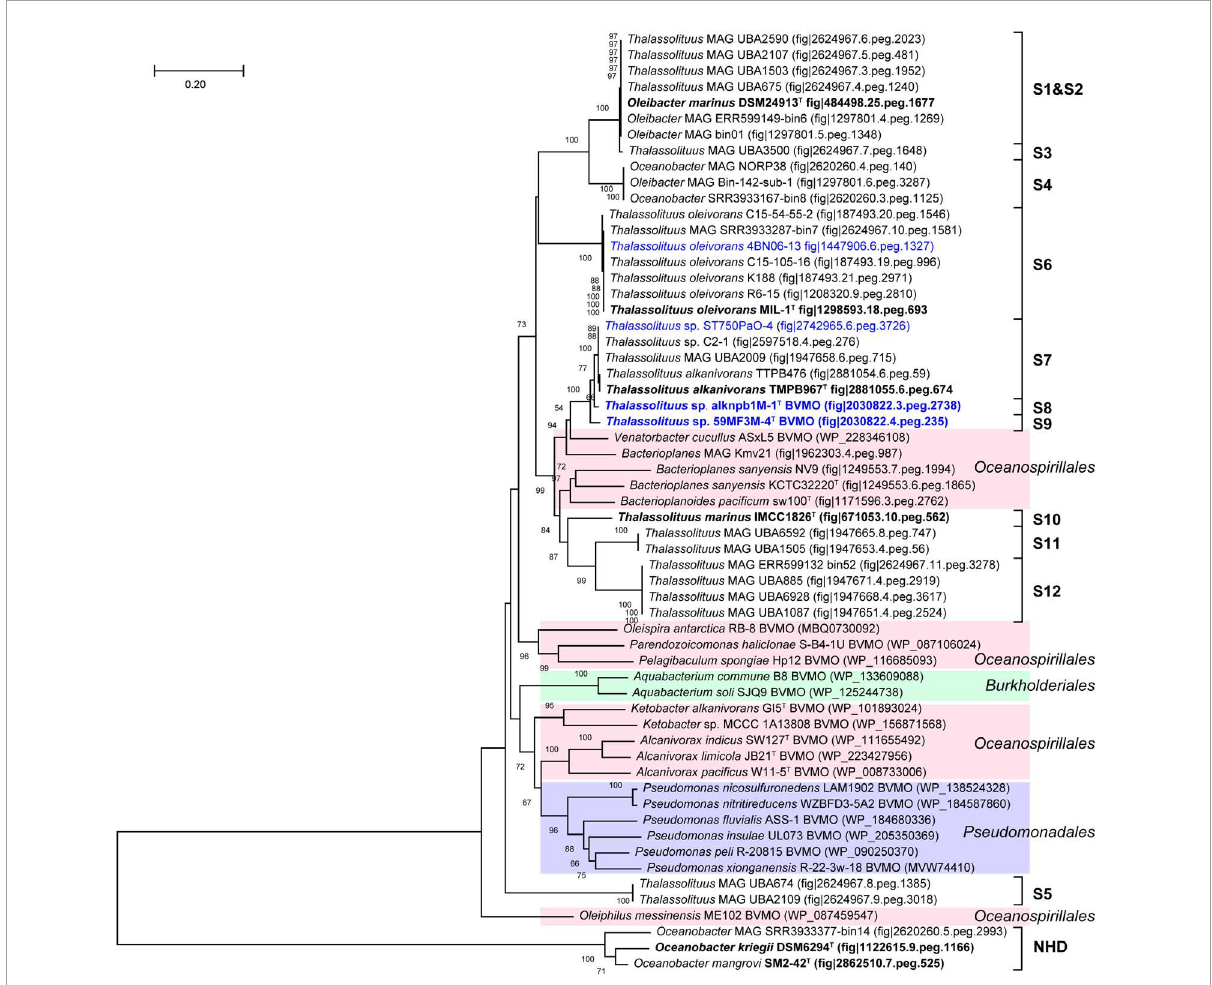
FIGURE8 Neighbor-joining phylogenetic tree of Baeyer-Villiger monooxygenase Baeyer-Villiger monooxygenase (BVMO) protein sequences derived from Oceanobacter -related bacteria (ORB) strains and their closest reference sequences. Bootstrap values ( > 50%) based on 1,000 resamplings are given at the nodes. The labels in blue and black bold font indicate the sequences obtained from the strains isolated in this study and the type strains of the ORB, respectively. Reference sequences in different shades of color indicate that they originated from different bacterial orders: red, Oceanospirillales ; purple, Pseudomonadales ; green, Burkholderiales